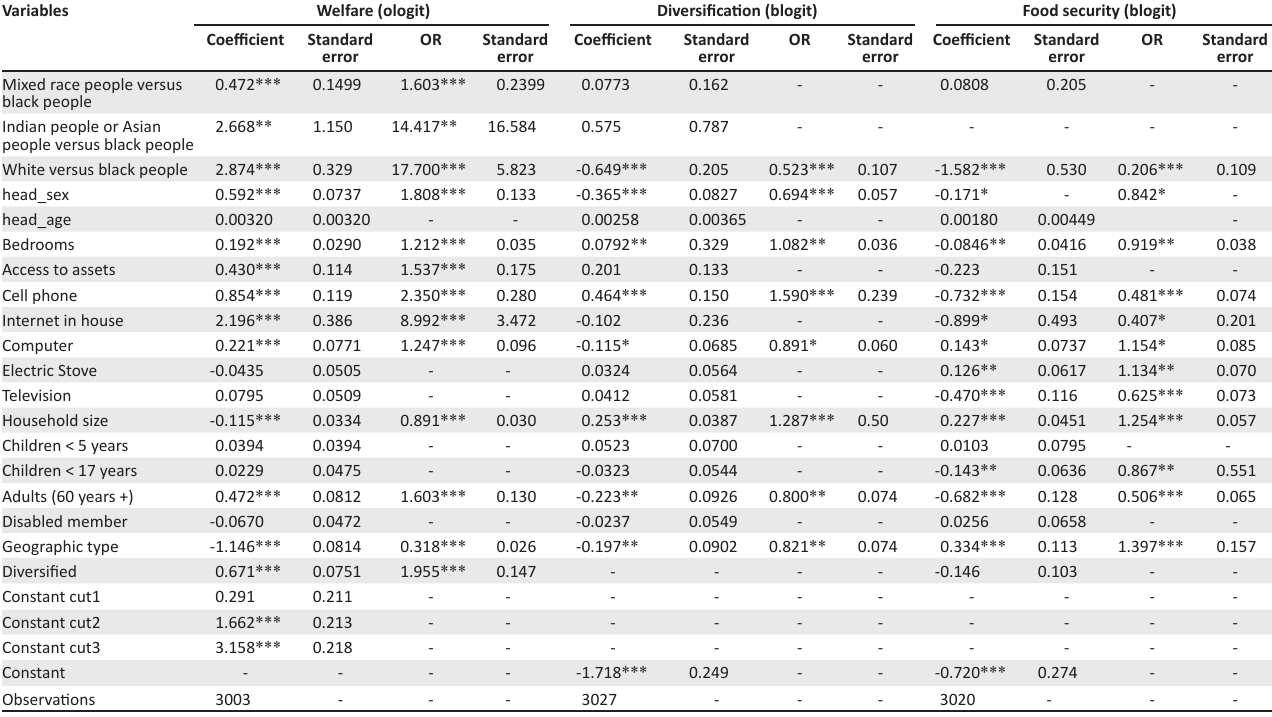
TABLE 8: Logistic regression. Variables Welfare (ologit) Diversification (blogit)